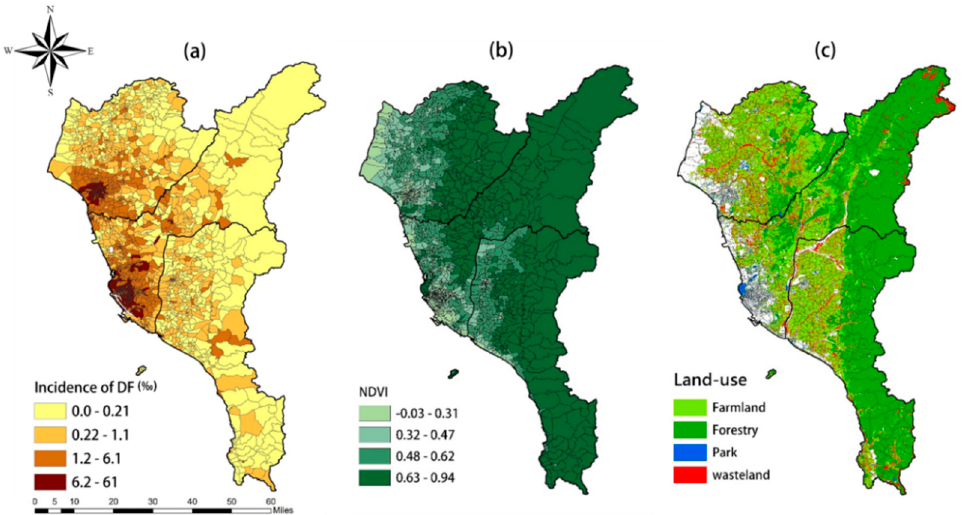
Figure 2. The spatial-temporal analysis of the ( a ) incidence of dengue fever, ( b ) NDVI, and ( c ) green land use.